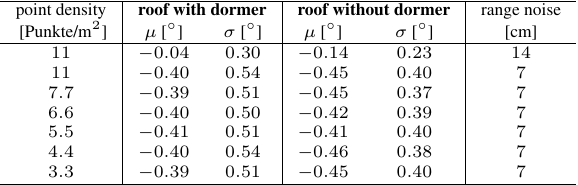
Table 7. Deviations between the estimated roof models using RanSaC and the true models. Mean and standard deviation of the differences with regard to the inclinations depending on the point density and noise are